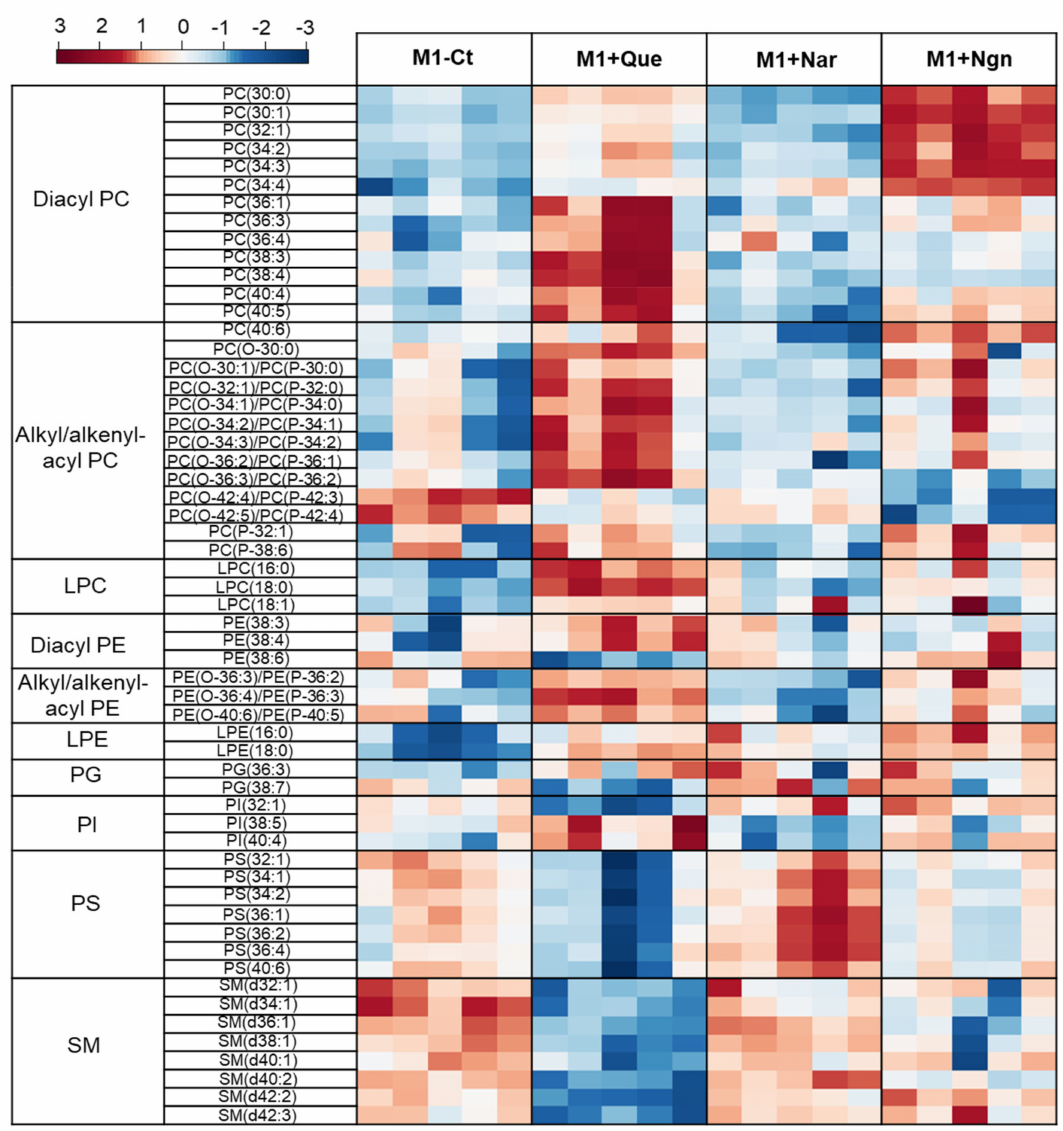
Figure 5. Heatmap representing the relative abundance of PL species found to be most important (VIP > 1) for discriminating between control M1 proinflammatory macrophages (M1-Ct) and flavonoid-treated M1 cells. The peak intensity values were normalized by total area, log-transformed and